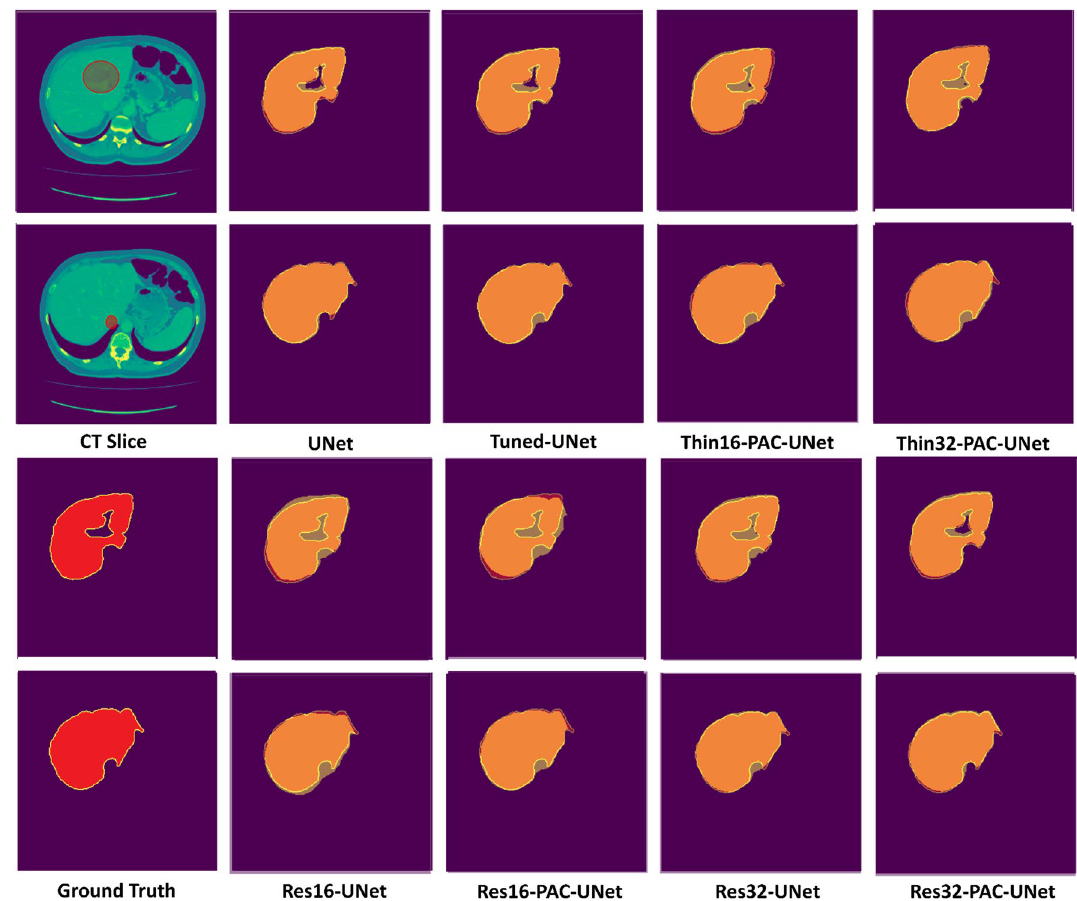
Figure 5. Qualitative comparison of the different segmentation masks generated by the proposed neural networks. The red bounding oval marks the presence of artifacts. The predicted segmentation masks (yellow) are overlaid on the ground truth (red) to highlight region